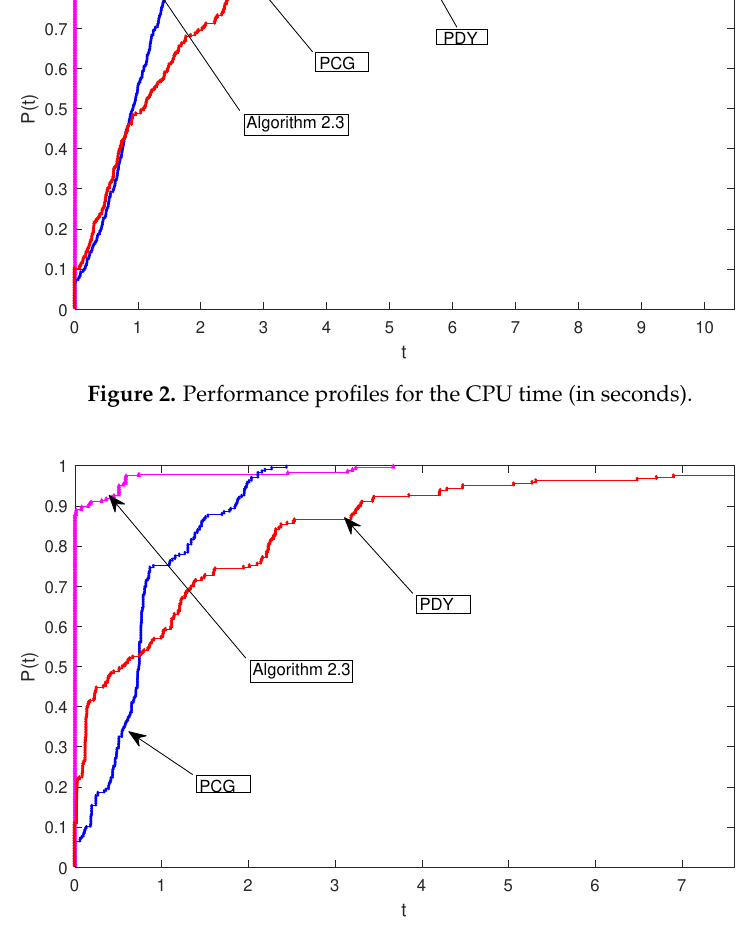
Figure 3. Performance profiles for the number of function evaluations.